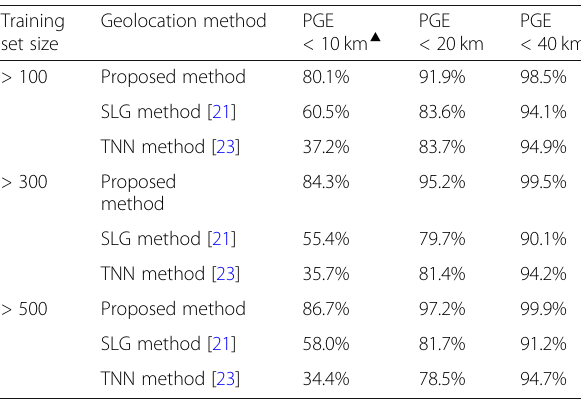
Table 4 The proportion of geolocation error when the threshold is